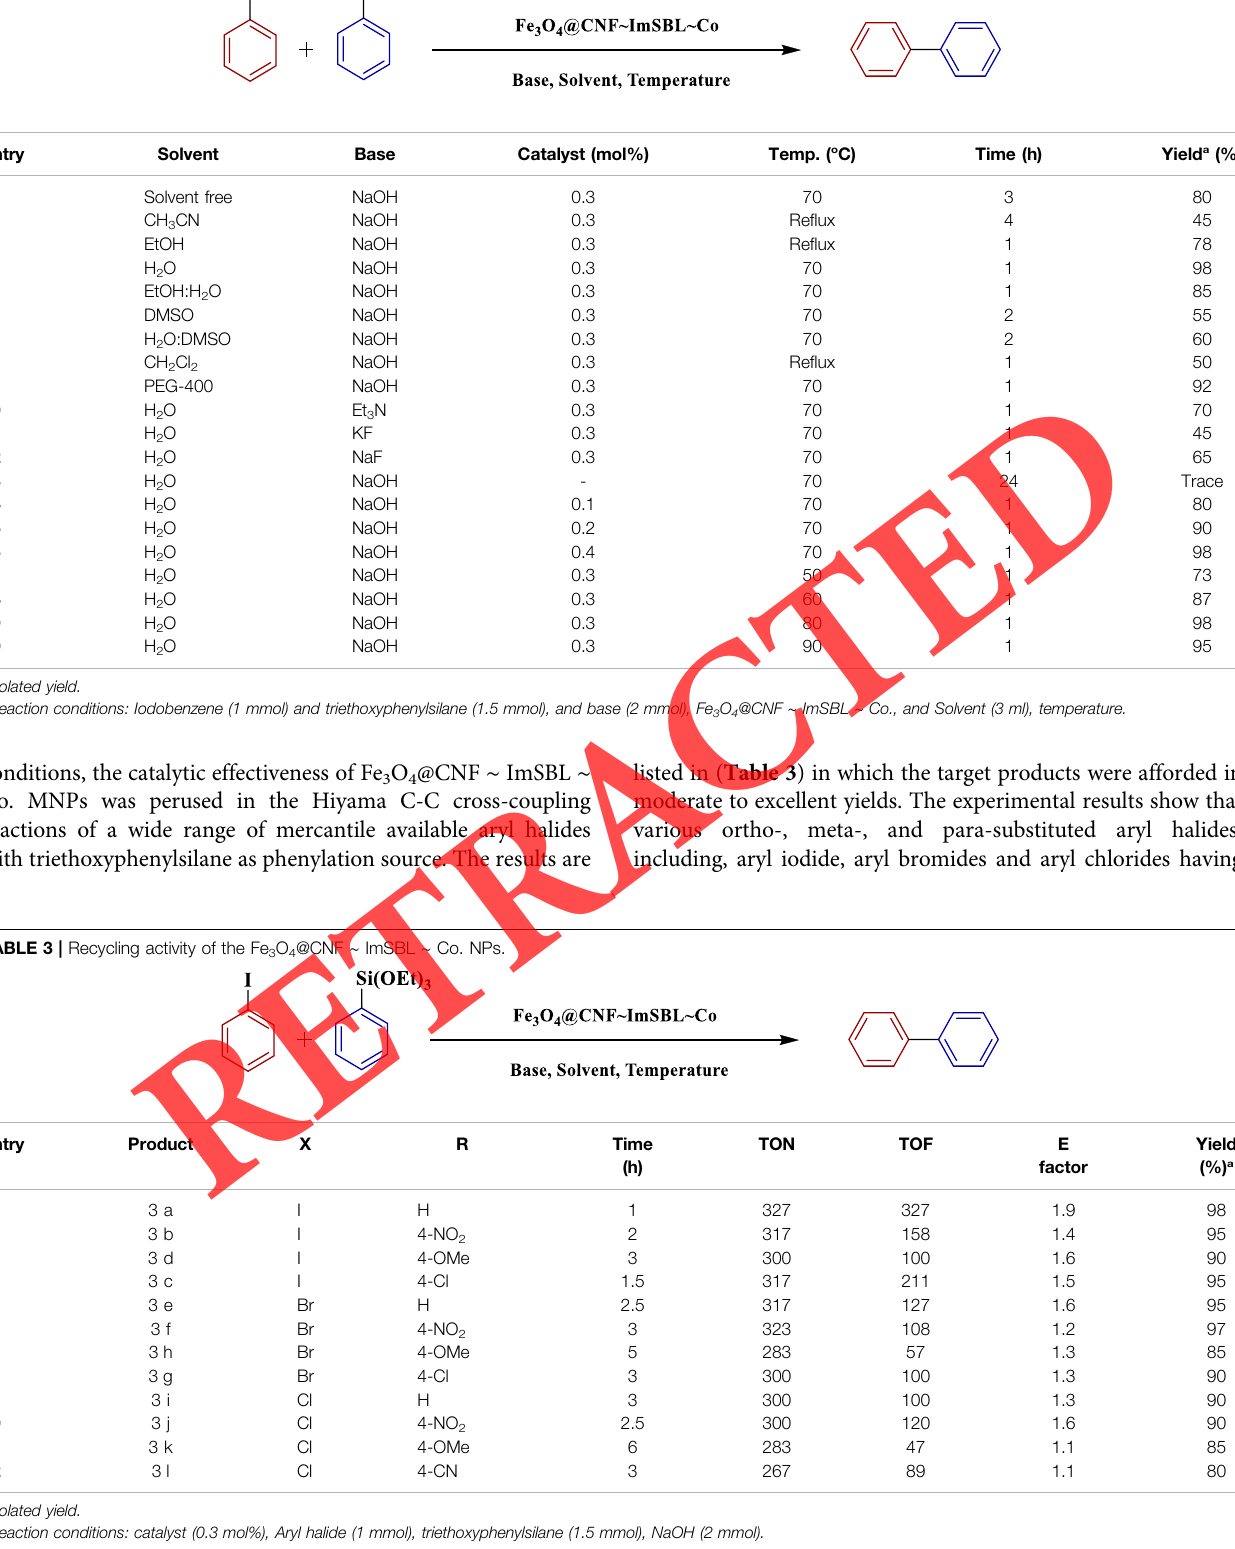
TABLE 2 | Optimization of the reaction conditions for the C-C cross coupling of iodobenzene with triethoxyphenylsilane.